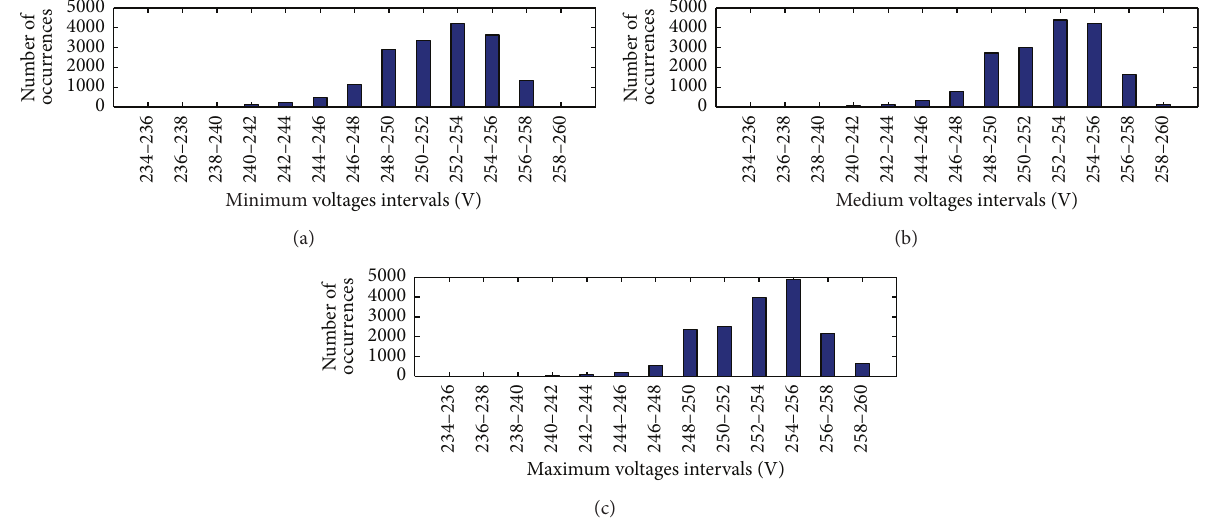
Figure 10: Statistical voltage distribution in the second